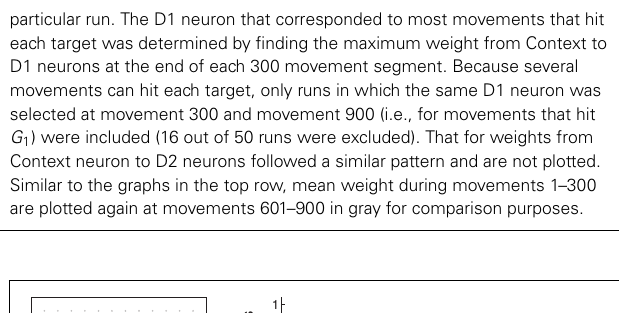
FIGURE 8 | Time-course of behavior and corticostriatal weights for Experiment 3: reinforce G 1 (movements 1–300), then G 2far (301–600), then G 1 again (601–900). Top: proportion of runs that hit G 1 (red) or G 2far (blue) as a function of movement number. The proportion of runs that hit G 1 during movements 1–300 are redrawn at horizontal positions 601–900 as a gray line for comparison of performance between initial acquisition (movements 1–300) and reacquisition (movements 601–900) of G 1 . Bottom: Mean (across runs) weight from Context neuron to the D1 neuron corresponding to most movements that hit G 1 (red) or G 2far (blue) for that